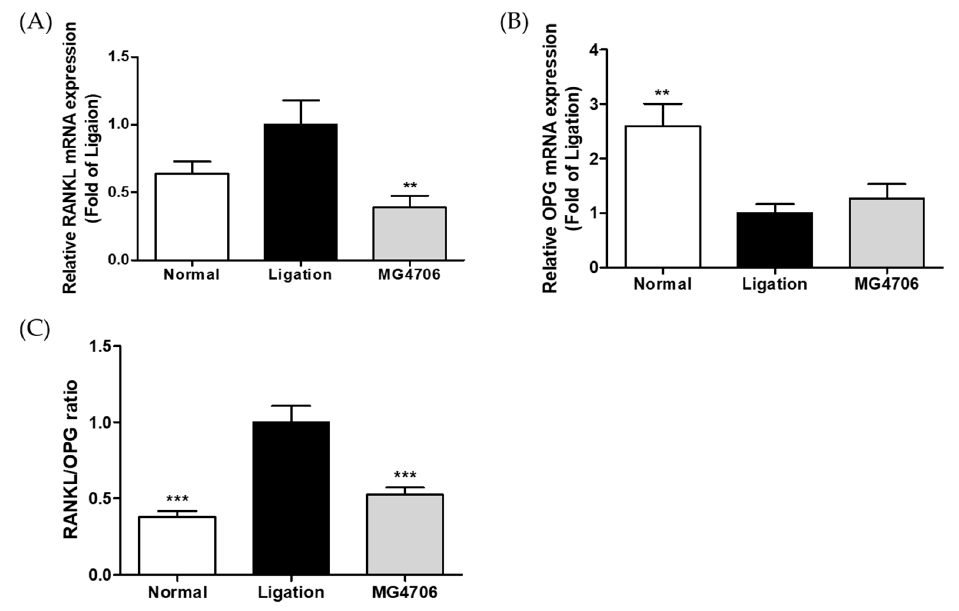
Figure 6. Effect of MG4706 on mRNA expression of ( A ) RANKL , ( B ) OPG , and ( C ) RANKL / OPG ratio in gingival tissue for ligatured-induced periodontal rats. Data are represented as mean ± SEM ( n = 8). Significance was analyzed using Dunnett’s test. ** p < 0.01, *** p < 0.001 versus ligation group.